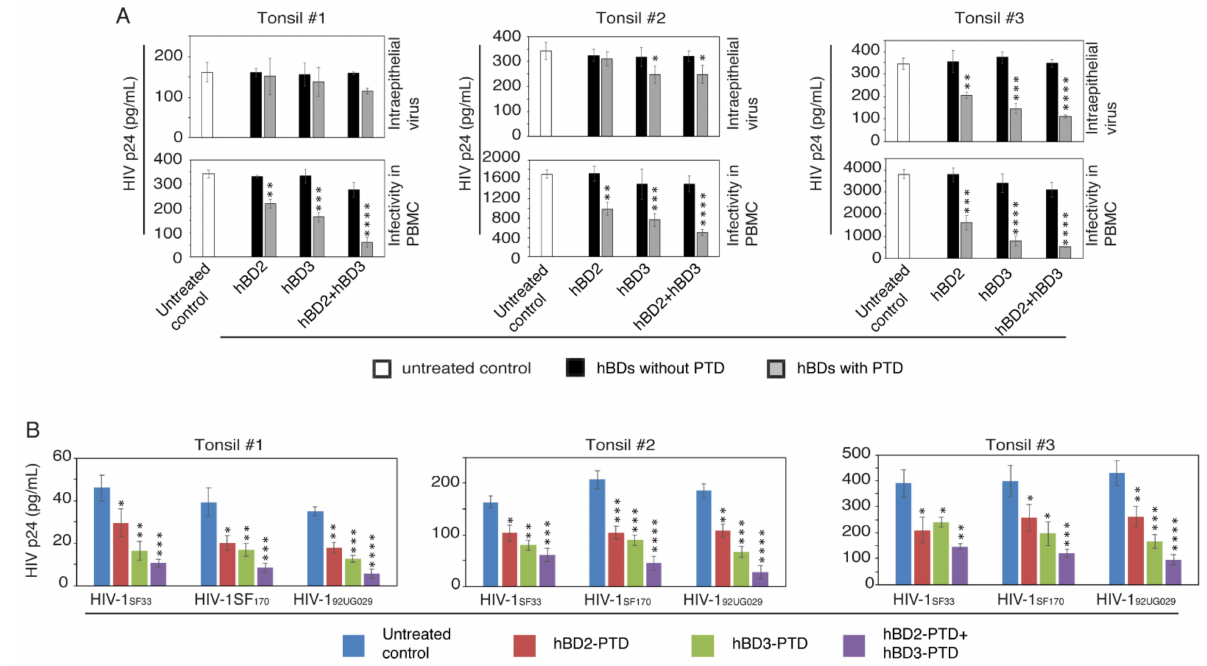
Figure 5. Internalization of hBD-2 PTD and hBD-3 PTD proteins into tonsil epithelial cells inactivated intravesicular HIV-1. ( A ) Polarized tonsil epithelial cells from three independent donors were exposed to HIV-1 SF33 (20 ng/mL), and after 48 h, cells were treated with hBD-2 or -3 (50 µ g/mL) with or without PTD signal for 2 h. One set of cells was treated with a combination of hBD-2 and -3 (50 µ g/mL each). Cells were then homogenized, and samples were divided into two groups. One group was examined by ELISA p24, which showed intraepithelial HIV-1. The second group was used to infect PBMC; after 7 days, PBMC were examined by ELISA p24, which showed the infectivity of intraepithelial virus. ( B ) Polarized tonsil epithelial cells from three independent donors were exposed to HIV-1 SF33 , HIV-1 SF170 , or HIV-1 92UG029 (20 ng/mL each); after 48 h, cells were treated with hBD-2 and -3 as described in panel A. Cell homogenates were used for infection of PBMC, and after 5 days, HIV-1 infection was examined by ELISA p24. Data are shown as mean ± SD ( n = 3). * p < 0.05, ** p < 0.01, *** p < 0.001, **** p < 0.0001 compared with untreated